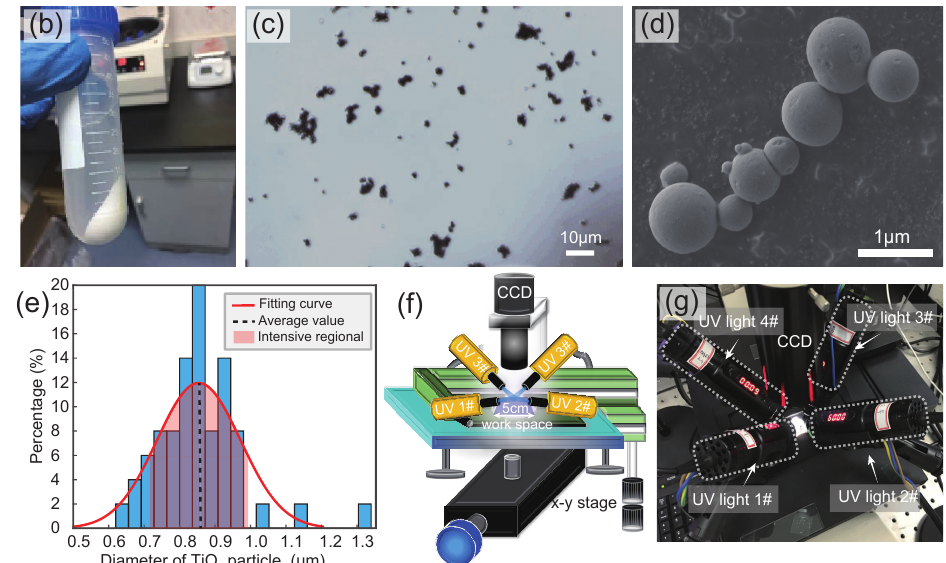
Figure 1. Characterization and optical control platform of the microrobots. ( a ) Schematic diagram of preparation principle and process of the TiO 2 microrobot. ( b ) Photo of the resulting TiO 2 microrobots in a centrifuge tube. ( c ) Observation results of TiO 2 microrobots under an optical microscope. ( d ) Characterization results of TiO 2 microrobot’s morphology under SEM. ( e ) Statistics and analysis results of TiO 2 microrobots’ diameters. ( f ) Schematic diagram of the multi-light-fields based optical driving platform. ( g ) A physical close-up view of the multi-light-fields-based optical driving